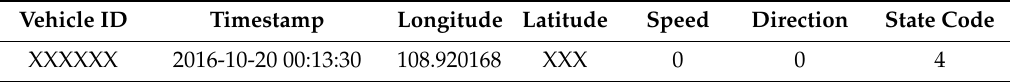
Table 1. Example of Raw Taxi Trajectory